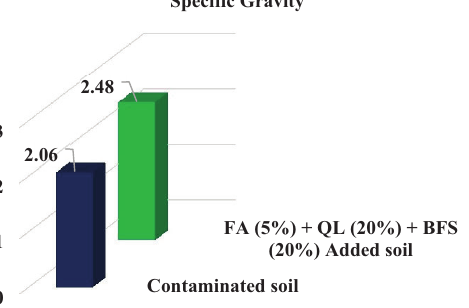
Contaminated Figure 4. Comparison of Specific Gravity values of contaminated and additives stabilized soil